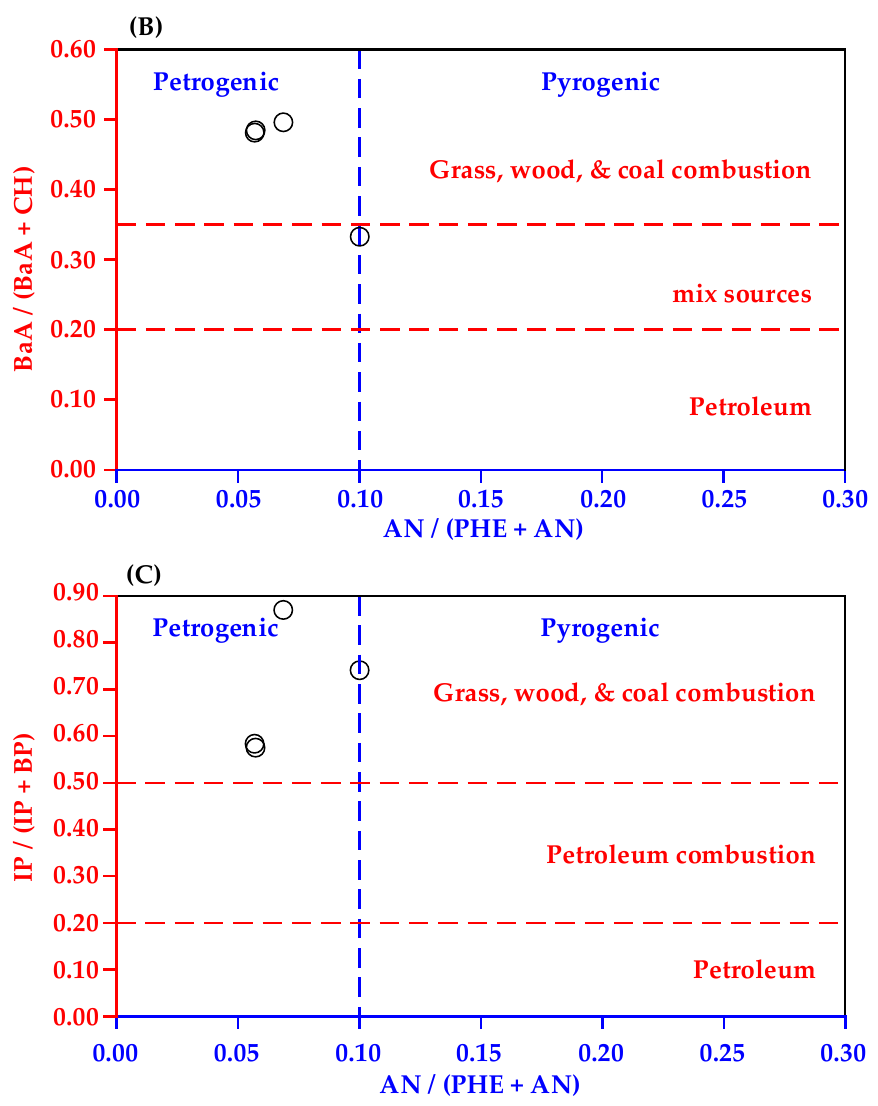
Figure 5. Diagnostic ratios of PAHs and possible sources in surface seawater collected offshore of southern Taiwan. AN/(PHE + AN) vs ( A ) FLU/(FLU + PY), ( B ) BaA/(BaA + CH), and ( C ) IP/(IP +